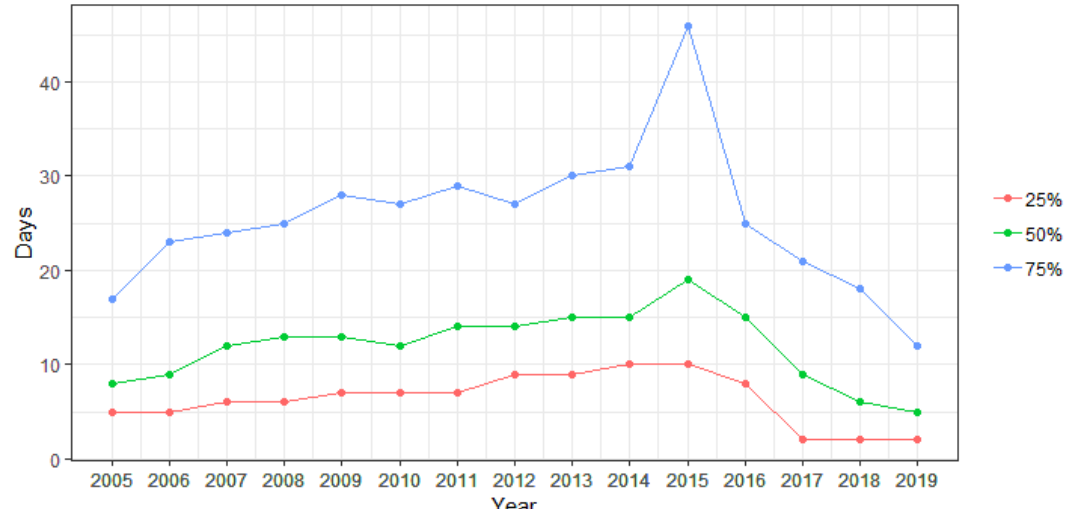
Figure 7. Turnaround time by year. Turnaround time is defined as the number of days from when the request is sent to the patient to when the answer is received.